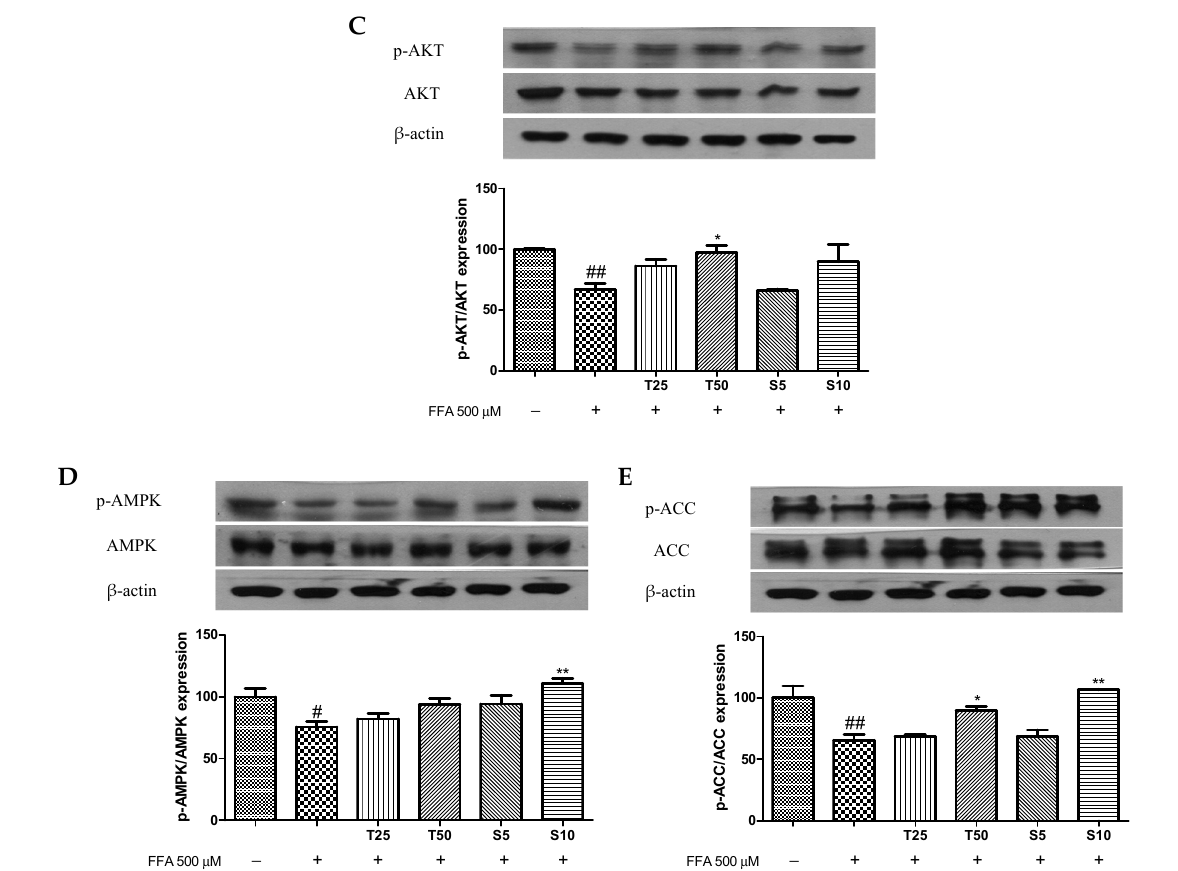
Figure 3. Effects of taxifolin and sorghum ethanol extract on phosphorylation of ( A ) IRS1, ( B ) PI3K, ( C ) AKT, ( D ) AMPK, and ( E ) ACC in HepG2 cells. Data are presented as the mean ± standard error (n = 3). # p < 0.05, ## p < 0.01 versus the control cells; * p < 0.05, ** p < 0.01 versus the FFA-treated group. FFA, free fatty acid; T, taxifolin ( µ M); S, sorghum ethanol extract ( μ g/mL).